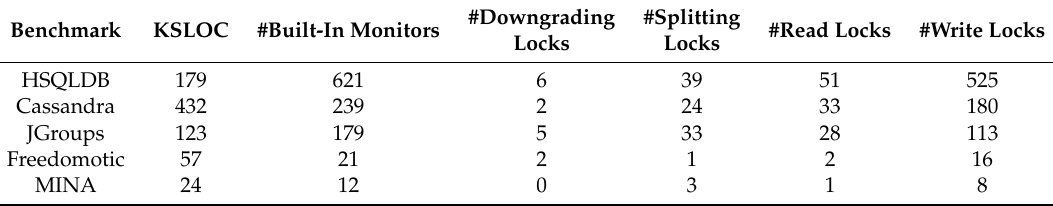
Table 2. Evaluation of the